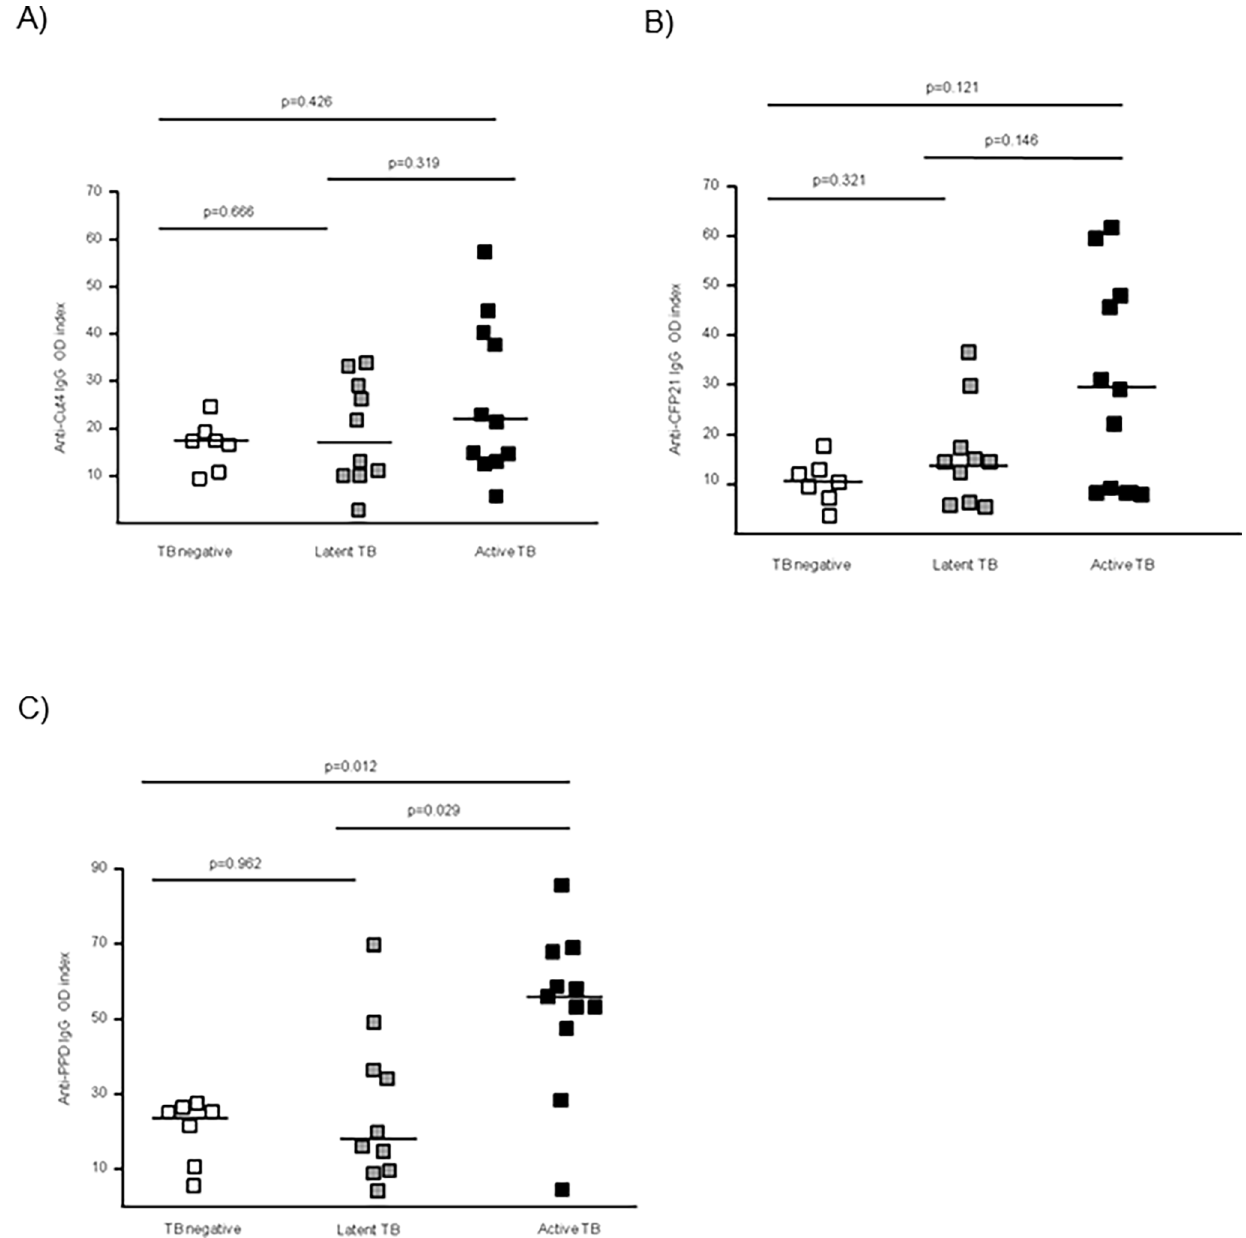
Fig 3. Serum antibody (IgG) levels against CFP21, Cut4 and PPD. The dot plots indicate level of antibodies directed against Cut4 (A), CFP21 (B), and PPD (C) in Mtb uninfected subjects, LTB subjects, and TB subjects. Antibodies levels are indicated per index of the optical density (OD), corresponding to the ratio of sample OD450nm/blank